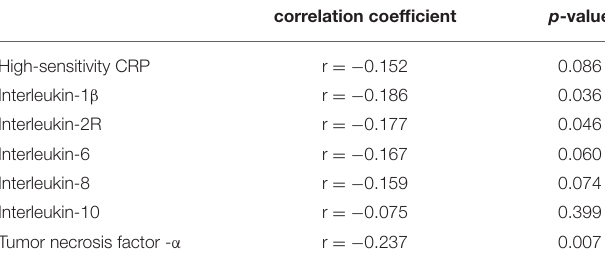
TABLE 3 | Correlation analysis between the percent change in brachial artery diameter caused by reactive hyperemia and inflammatory biomarkers in survivors of